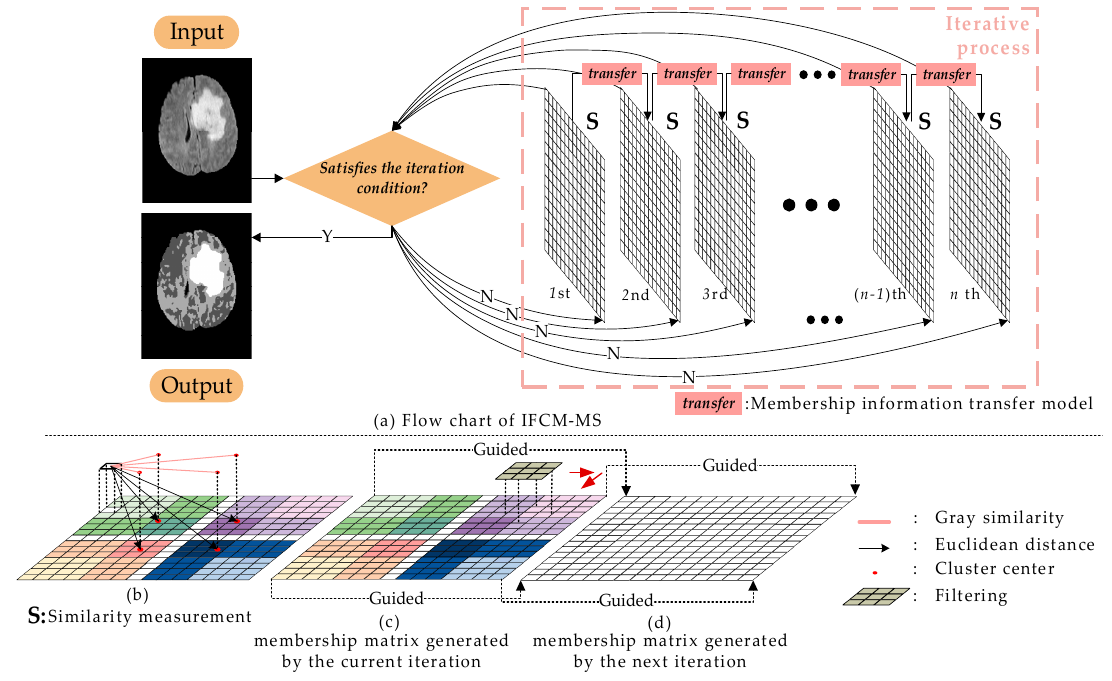
Figure 1. Overall flow chart. ( a ) Flow chart of IFCM-MS. ( b ) Similarity measurement. ( c ) Membership matrix generated by the current iteration. ( d ) Membership matrix generated by the next iteration. ( b , c ) Membership information transfer model.